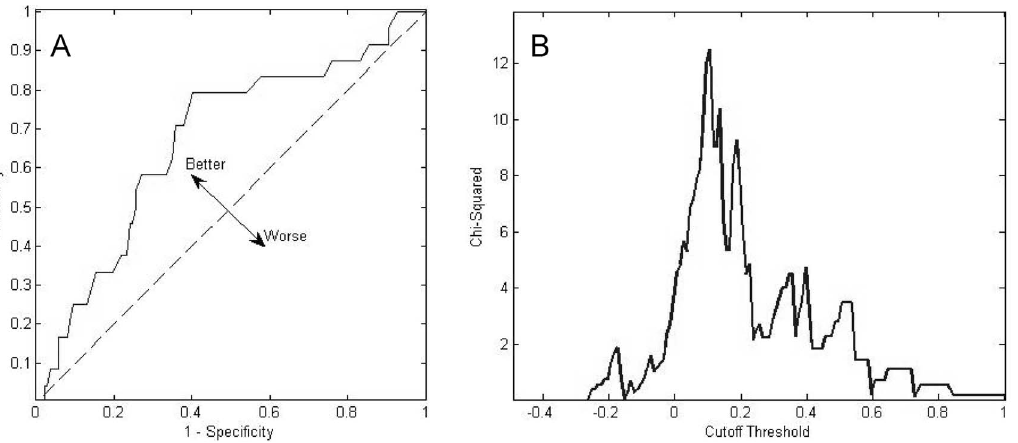
Figure 1. A: ROC plot of COP displacement variable. Sensitivity and 1-Specificity are plotted as the cutoff value is varied. The ideal location is in the upper left hand quadrant (1,0), where 100% of fallers are detected and 0% of non-fallers are identified (no false positives). The dotted line (line of no-discrimination) represents the location of a value with no predictive value (catches the same percentage of both fallers and non-fallers). B: Plot of chi squared value versus cutoff threshold. Values over 3.84 have a significance of p , 0.05, and values over 10.83 have significance of p , 0.001. Data from other variables result in similar values.